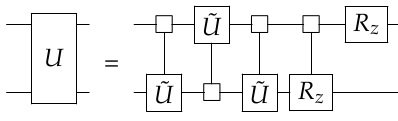
Figure 9. Recursive CSD decomposition [21].